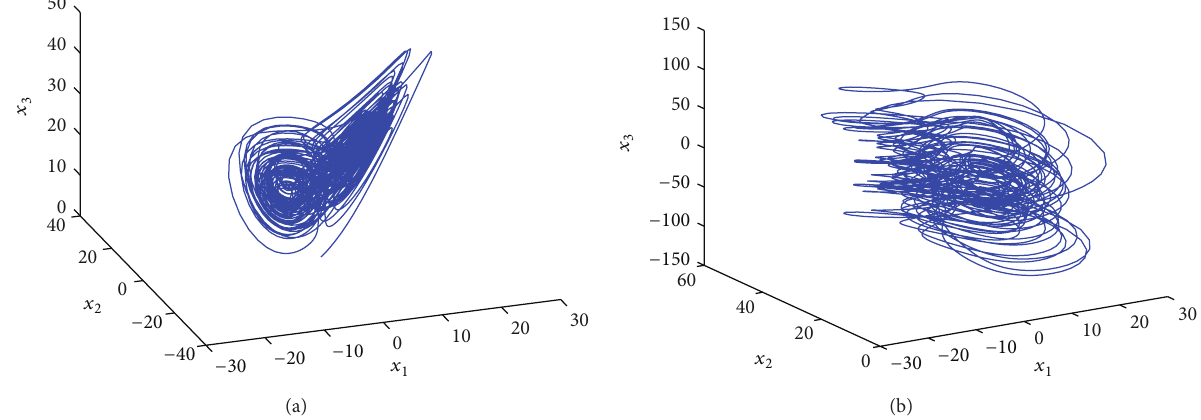
Figure 7: Hyperchaotic attractors in the fractional hyperchaotic L¨u system with 𝛼 = 0.95 . The panels (a) and (b) show the 3D views of − 𝑥 − 𝑥 𝑥 − 𝑥 − 𝑥 𝑥 3 2 1 and 4 3 2 ,